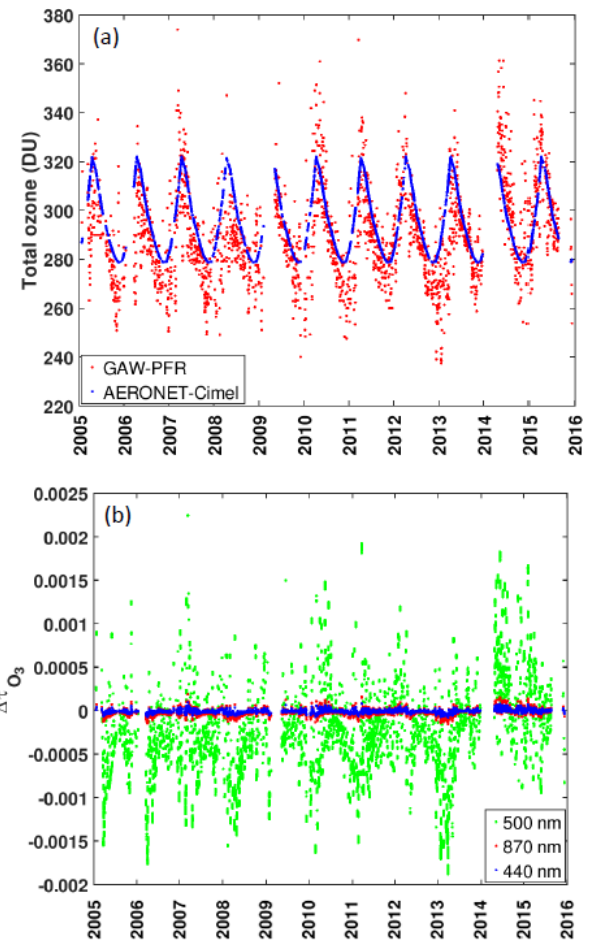
Figure 5. (a) Total O 3 used by GAW-PFR (measured Brewer O 3 values from IZO, OMI O 3 overpass or Brewer O 3 climatology) and AERONET-Cimel (TOMS O 3 climatology) and (b) (cid:49)τ O caused by differences in daily total O 3 between the two instruments in the period